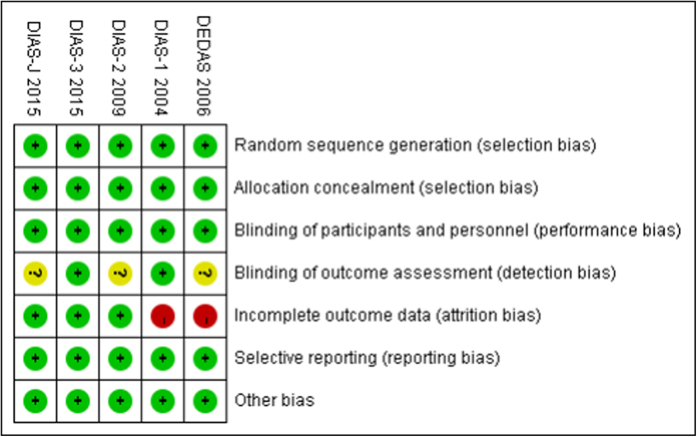
Risk of bias: A summary table for each risk of bias item for each study.